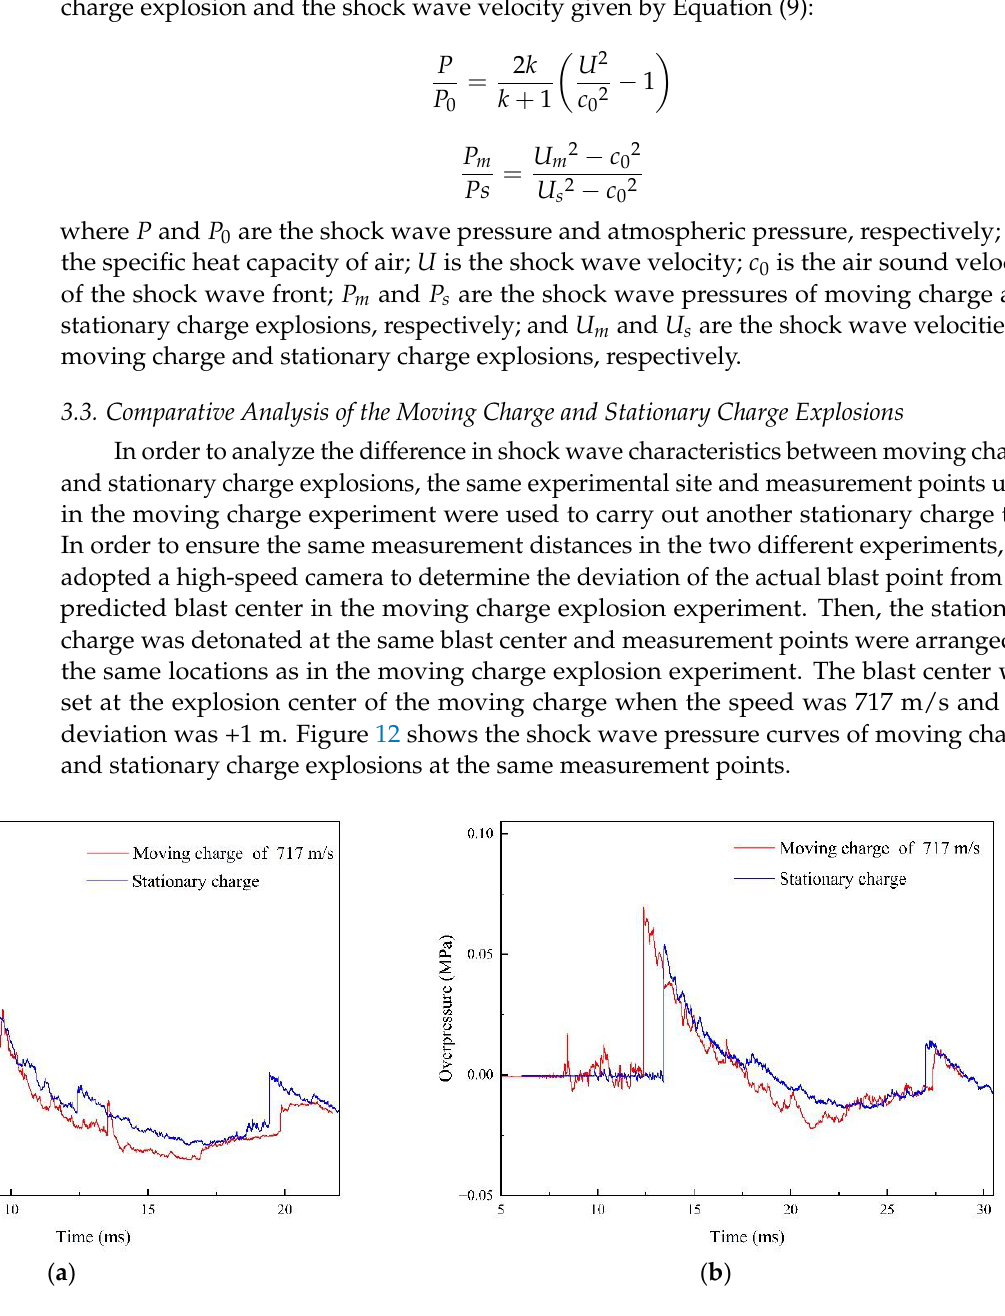
Figure 12. Shock wave overpressure–time history curves of the moving charge and stationary charge explosions: ( a ) test point #1 at 5 m in the 0° direction and ( b ) test point #4 at 7.28 m in the 16° direction.